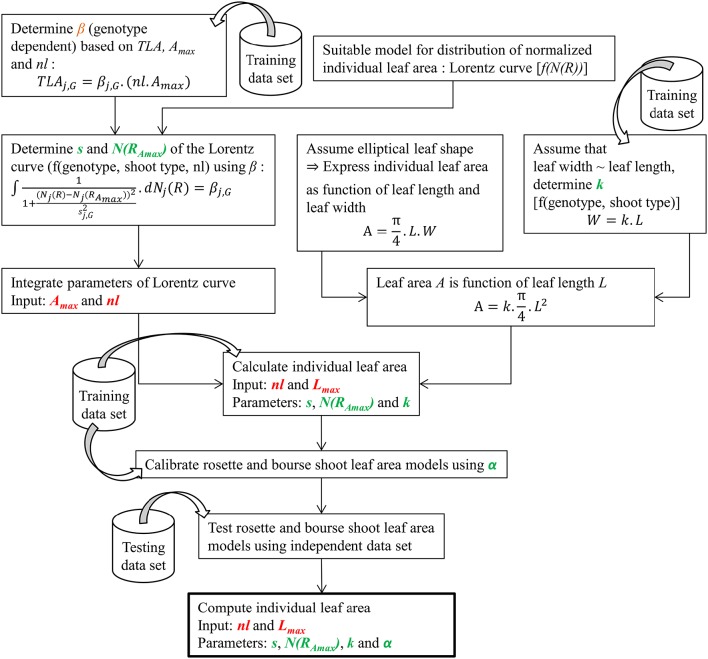
Diagram summarizing the steps involved in modeling bourse shoot and rosette individual leaf area (for further explanations see text and equations).